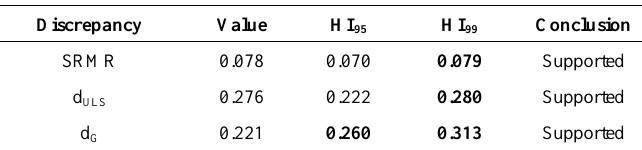
Table 2. Model fit